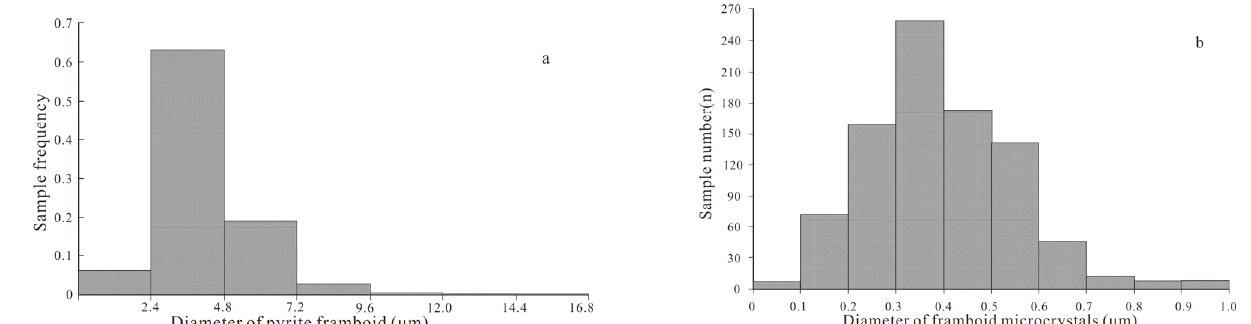
Figure 4. ( a ) Distribution of the diameter of pyrite framboids in the Wufeng and Longmaxi Formations; ( b ) Distribution of the diameter of framboid microcrystals in the Wufeng and Longmaxi Formations